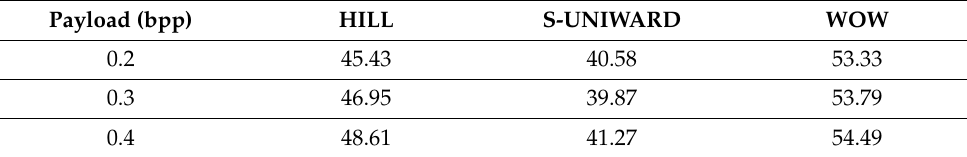
Figure 6. Block diagram of the proposed CNN.